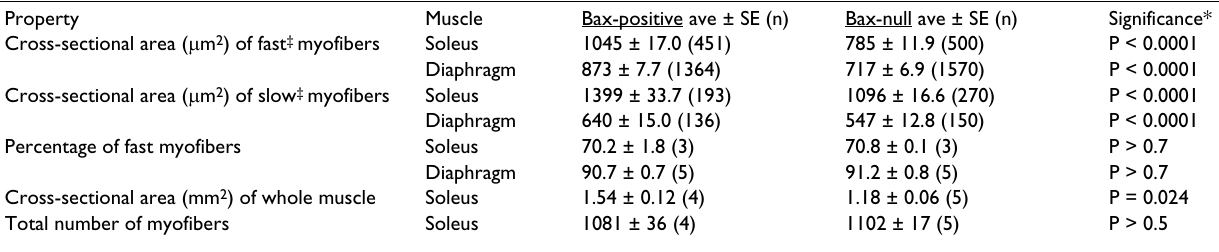
Table 2: Effect of Bax genotype on properties of myofibers in vivo .